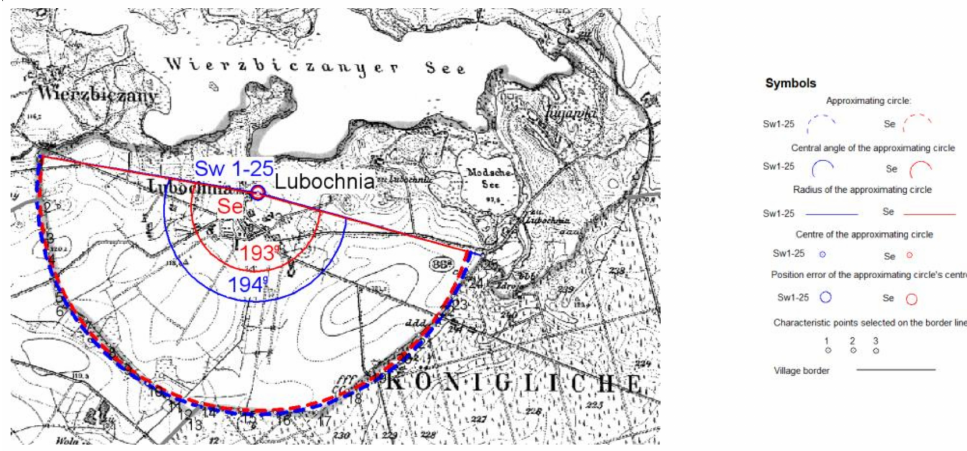
Figure 8. Lubochnia. Course, position and error of the approximating circle: Sw 1—25— approximation of points 1—25, Se—approximation of points 1—25, without points 13, 25. Scale 1:50,000.